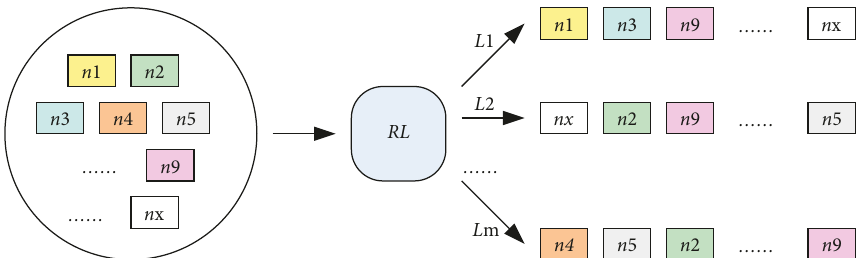
Figure 1: Basic rocket ship design. The rocket ship is propelled with three thrusters and features a single viewing window. The nose cone is detachable upon